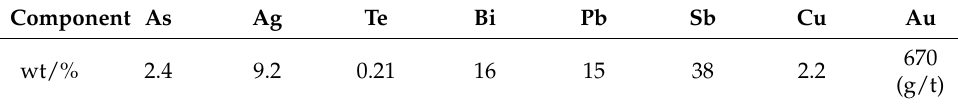
Table 1. Chemical compositions of TLAS (tellurium-rich lead anode slime) (wt%). Component